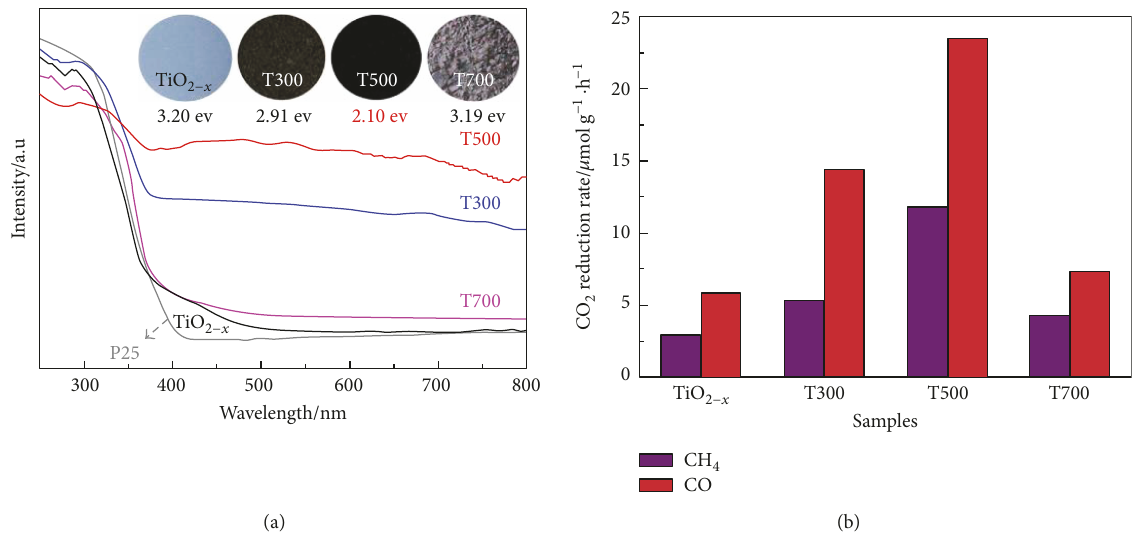
Figure 10: (a) UV-vis di ff use re fl ectance spectra and (b) CO TiO by hydrothermal reaction. T300, T500, and T700 are the products after postannealing treatment at 300, 500, and 700 ° C, respectively. 2 Reprinted with permission from [89]. Copyright (2016) Nature Publishing Group.